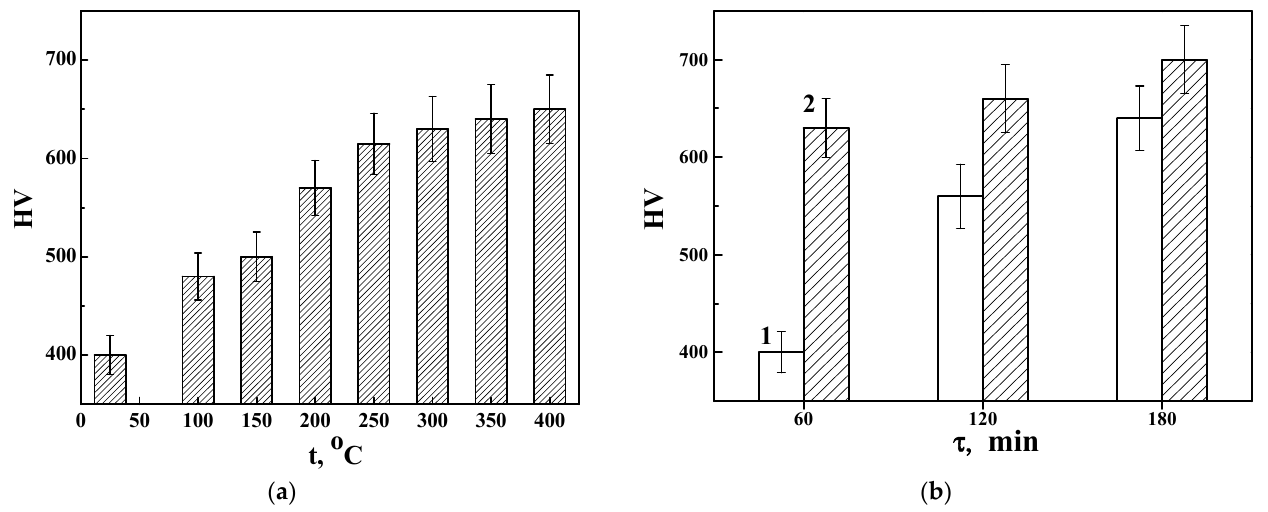
Figure 11. Changes in the microhardness HV of hard anodized layers on aluminum alloy 1011 depending on ( a ) heat treatment temperature t with specimens holding at it for 1 h and ( b ) duration of the anodizing process τ without heat treatment of specimens (1) and after holding them at 300 °C for 1 h (2).